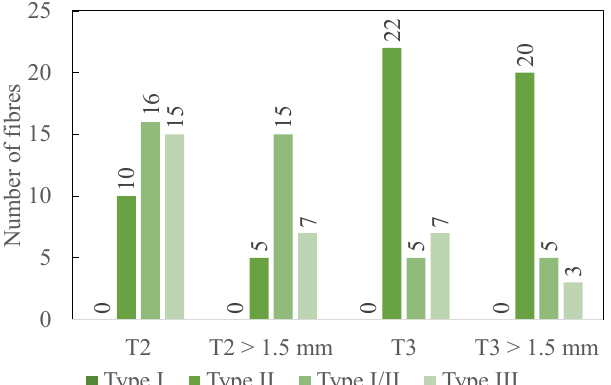
Figure 10. Experimental results: number of delaminated fibres (total and longer than 1.5 mm) after the up milling for 240 mm (2 coupons) for T2 and T3 at the worn state-average values for one cou- pon.